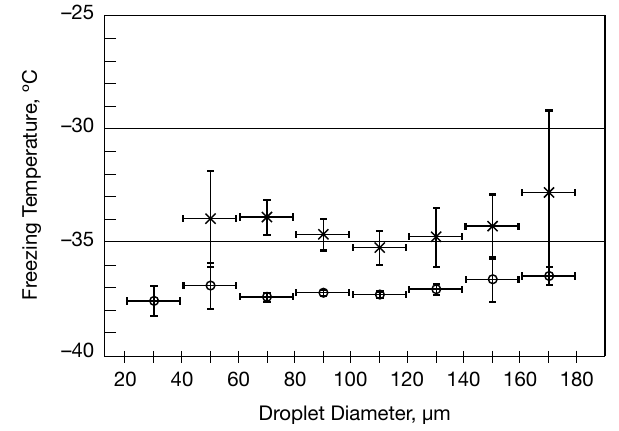
Fig. 7. Combined data for mean freezing temperatures against binned droplet diameters (20µm wide intervals for each droplet di- ameter size bin) from homogeneous ( (cid:13) ) and heterogeneous ( × ) nucleation experiments. Horizontal lines provide ranges for each of the 20µm diameter size bins. Vertical lines represent bounds for the 95% confidence interval about each